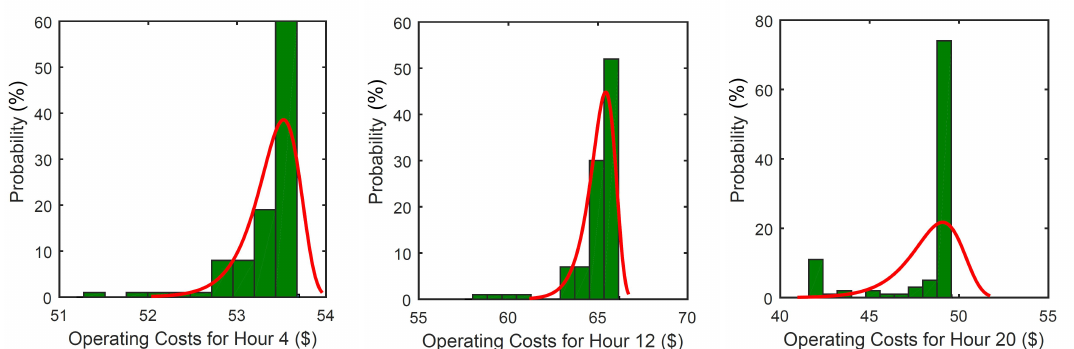
Figure 12. Probability of the operating cost on the 4th hour ( left ), 12th hour ( center ), and 20th hour ( right ) of the 21 December case